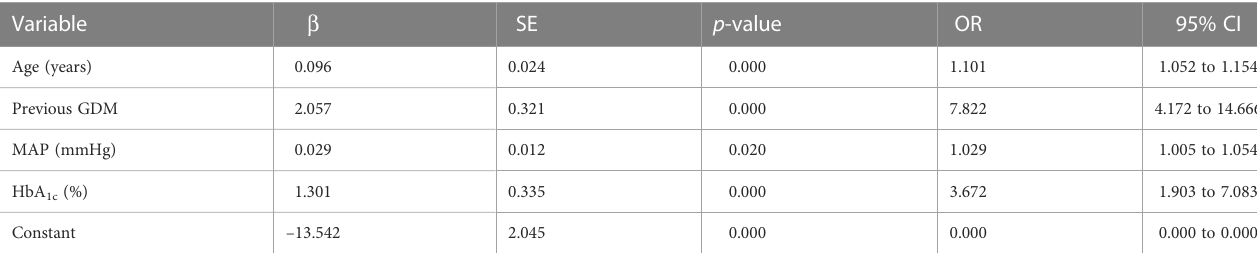
Constant LR, logistic regression; OR, odds